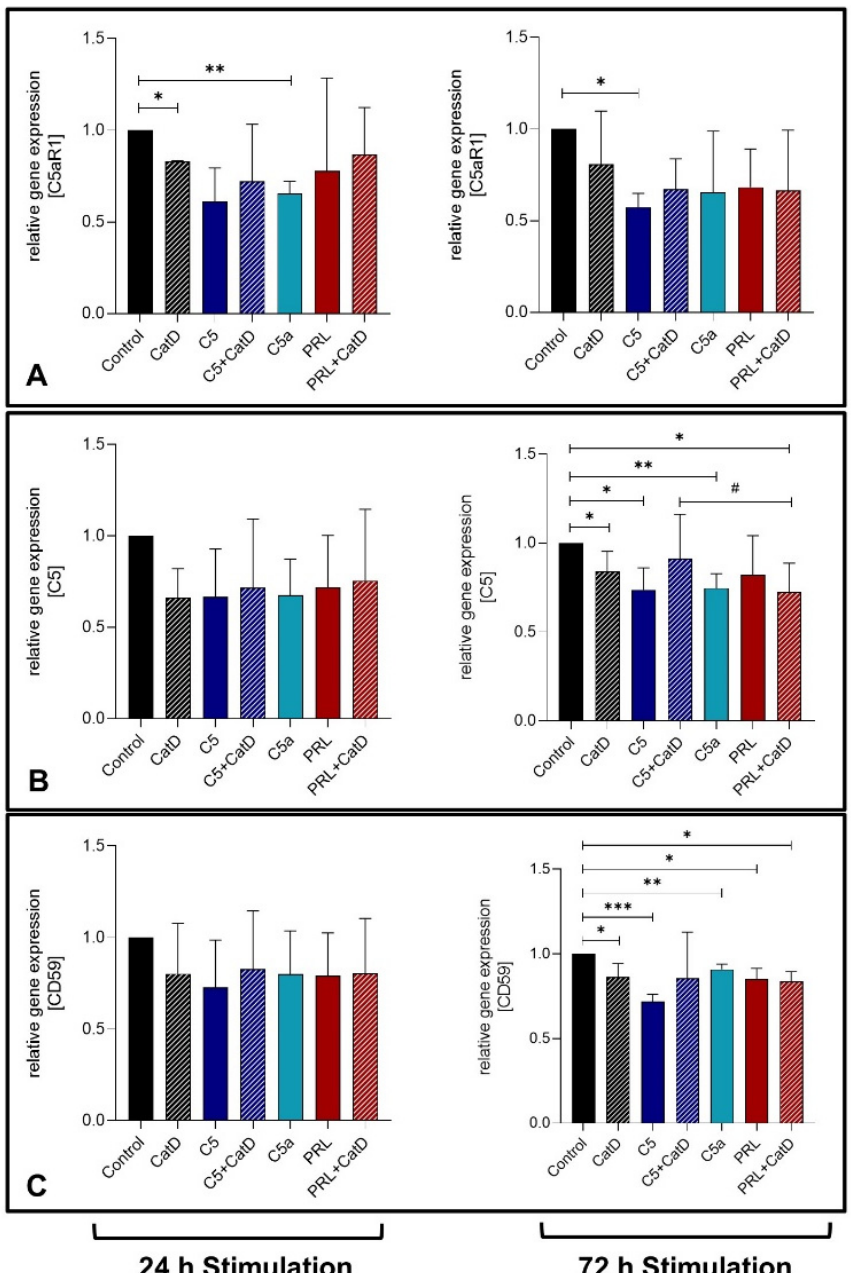
Figure 2. Graphic representation of relative chondrocytes gene expression of C5aR1 ( A ), C5 ( B ), and CD59 ( C ) after 24 h and 72 h of stimulation. n = 3 (24 h stimulation) and n = 5 (72 h stimulation) independent experiments with chondrocytes from different donors. Mean with standard deviation. Control has been normalized to 1. One sample t -test with significance in relation to control (*). Mixed-effects analysis using post-hoc Tukey’s multiple comparisons (#). */# = p ≤ 0.05; ** = p ≤ 0.01, *** = p ≤ 0.001.